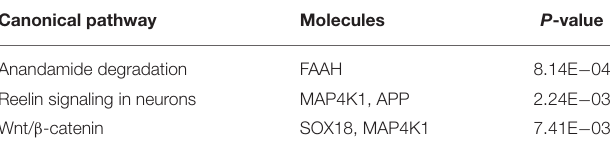
TABLE 4 | Significantly enriched canonical pathways identified by IPA. Canonical